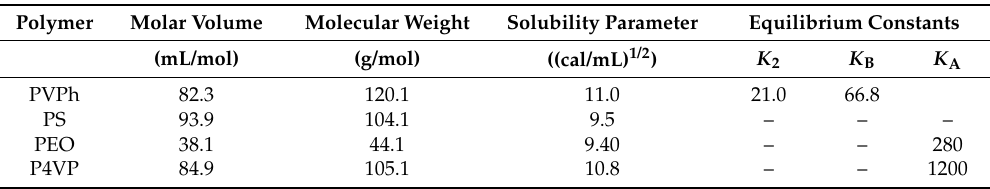
Table 1. Molecular volume, molecular weight, solubility parameter, and equilibrium constants of various polymer segments used in this